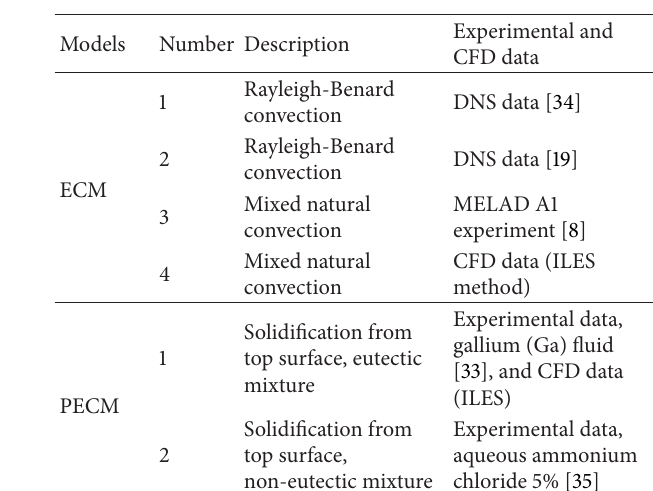
Table 1: ECM and PECM validation